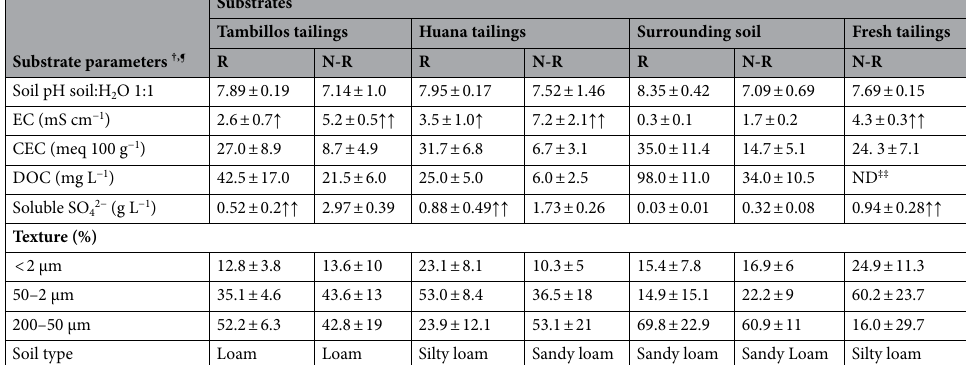
copper flotation processes and was abandoned in 1998. Along with these substrates, characterization of the rhizosphere and non-rhizosphere of a control soil (from the vicinity of Huana tailings) was initially performed. Some of the parameters analyzed were also compared to a freshly produced tailing substrate from the Tambillos site (fresh tailings) (Table 1). Determination of pH in water extracts showed that all tailing substrates were neu- tral to slightly alkaline (7.14 to 7.95) (Table 2). Rhizosphere substrates showed a higher pH than non-rhizosphere substrates, a trend also observed in surrounding soil samples, where the rhizosphere compartment reached pH up to 8.35. Cation exchange capacity, as well as the dissolved organic carbon content of rhizosphere substrates, were also higher than those of non-rhizosphere counterparts in all locations under study, reaching the highest value in the rhizosphere of surrounding soil. Electrical conductivity values in the rhizosphere substrates were lower than in their corresponding non-rhizosphere substrates. However, the values observed in tailing samples exceeded those favorable for plant growth 18 , being especially high in non-rhizosphere tailing substrates and fresh Tambillos tailings (Table 2). Soluble sulfate concentrations were in the very high range in all the analyzed compartments, compared to those of surrounding soil rhizosphere and non-rhizosphere (Table 2). Texture analysis of substrate samples showed a greater proportion of fine-sized particle material (lower than 50 µm) in the rhizosphere of Huana and fresh Tambillos tailings (76.1% and 85.1%, respectively). Those of Tambillos tailings and surrounding soil (47.9% and 30.3%, respectively) (Table 2), were clearly lower. About one-fourth of total material in the rhizosphere of Huana and fresh Tambillos tailings corresponded to particles smaller than 2 µm (23.1% and 24.9%, respectively). In order to compare the potential of rhizosphere tailing substrates to support plant growth in terms of macro- nutrient availability and saline concentrations, their nutritional status and main cationic components were deter- mined (Supplementary Table S1 online). Standard analytical soil tests 19 indicated that organic matter contents were very low in almost all the analyzed substrates. Unexpectedly, organic matter content in fresh tailings was three times higher than in the surrounding soil and in Tambillos tailings, and six times higher than in Huana tailings. Available N and P levels were lower in all tailing substrates relative to the surrounding soil rhizosphere, with the level of available P in Huana tailings rhizosphere being extremely low (Supplementary Table S1 online). Root‑associated microbial community in B. linearis inhabiting abandoned tailings. The micro- bial community associated to individuals of B. linearis naturally occurring in Huana and Tambillos tailings, as well as the surrounding soil, were characterized. Three compartments: the rhizoplane (substrate adhered to the roots), the rhizosphere and non-rhizosphere substrates, were considered. T-RFLP profiles of the more abundant species in bacterial communities were first compared by non-metric multidimensional scaling (NMDS) analysis of the corresponding samples, using Bray–Curtis distance matrices. Results showed a clear clustering among most rhizoplane samples (Fig. 1A). Two-way ANOSIM comparisons between “root compartment” and “locali- zation” groups indicated that observed grouping (by root compartment) was statistically supported with a global R-value of 0.51 (p = 0.001). This suggested moderate to high differences in the taxonomic composition according to Clarke 20 , i.e. an R-value ranging from 0.5 to 1. These results were also supported by ANOSIM pairwise test. Pairwise test by localization revealed minor differences in bacterial community composition between Huana tailings/surrounding soil, Tambillos tailings/surrounding soil, or Huana tailings/Tambillos tailings pairs (R-val- ues of 0.003, 0.296, and 0.256, respectively). Alpha diversity indices were estimated using T-RFLP profiles, relative abundances for the dominant opera- tional taxonomic units obtained from Huana and Tambillos tailings, and surrounding soil, and compared by “root compartment” and “localization” as factors (Supplementary Table S2 online). H´ diversity index values were 2.06 ± 0.61, 2.94 ± 0.49, and 3.20 ± 0.20 for rhizoplane, rhizosphere, and non-rhizosphere, respectively,